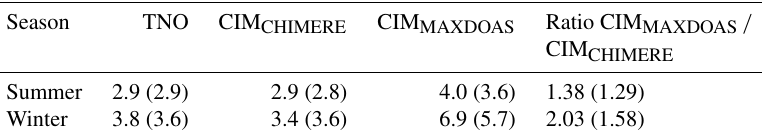
Table 4. Comparison of the daily average NO x emissions from TNO with those derived from CHIMERE (CIM CHIMERE ) and car MAX- DOAS (CIM MAXDOAS ) for days with errors in the car MAX-DOAS data<100% and differences in the CIM results for CHIMERE and TNO emissions<70%. For the calculation of the average, the daily values are weighted by their individual errors. The values in brackets are calculated for all days. Emissions are given as 10 25 molecNO x per